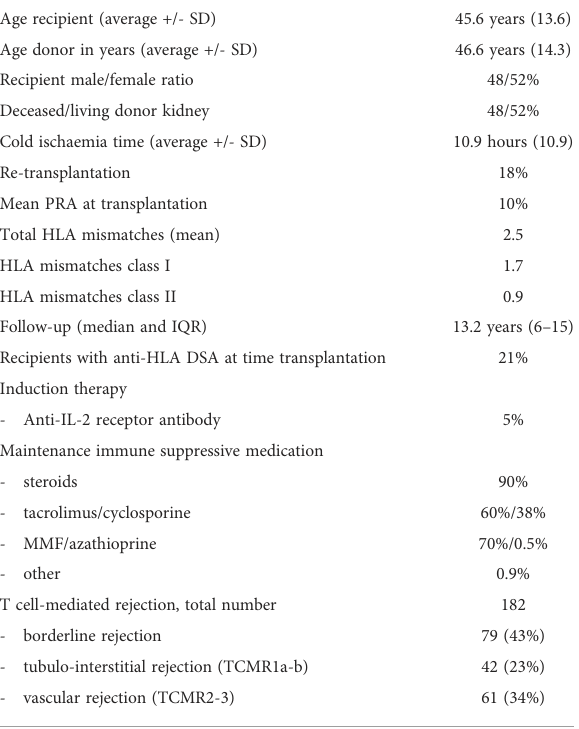
PRA:panel reactive antibodies, DSA:donor speci fi c anti-HLA